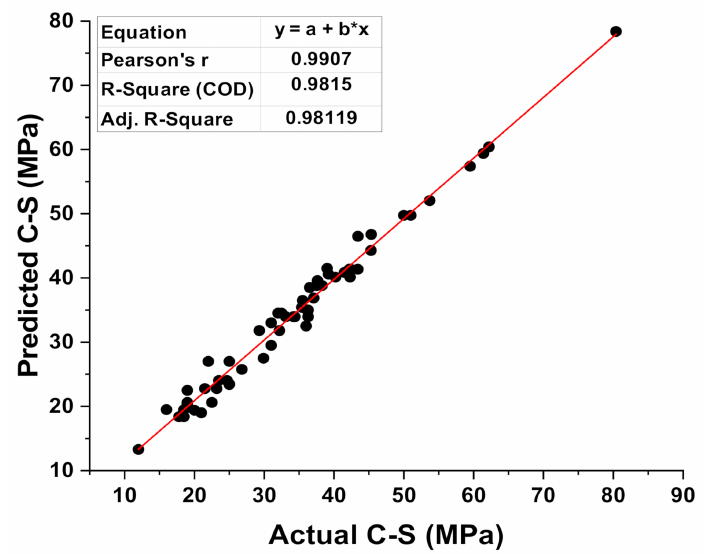
Figure 7. Correspondence among the experimental and predicted result of XGB